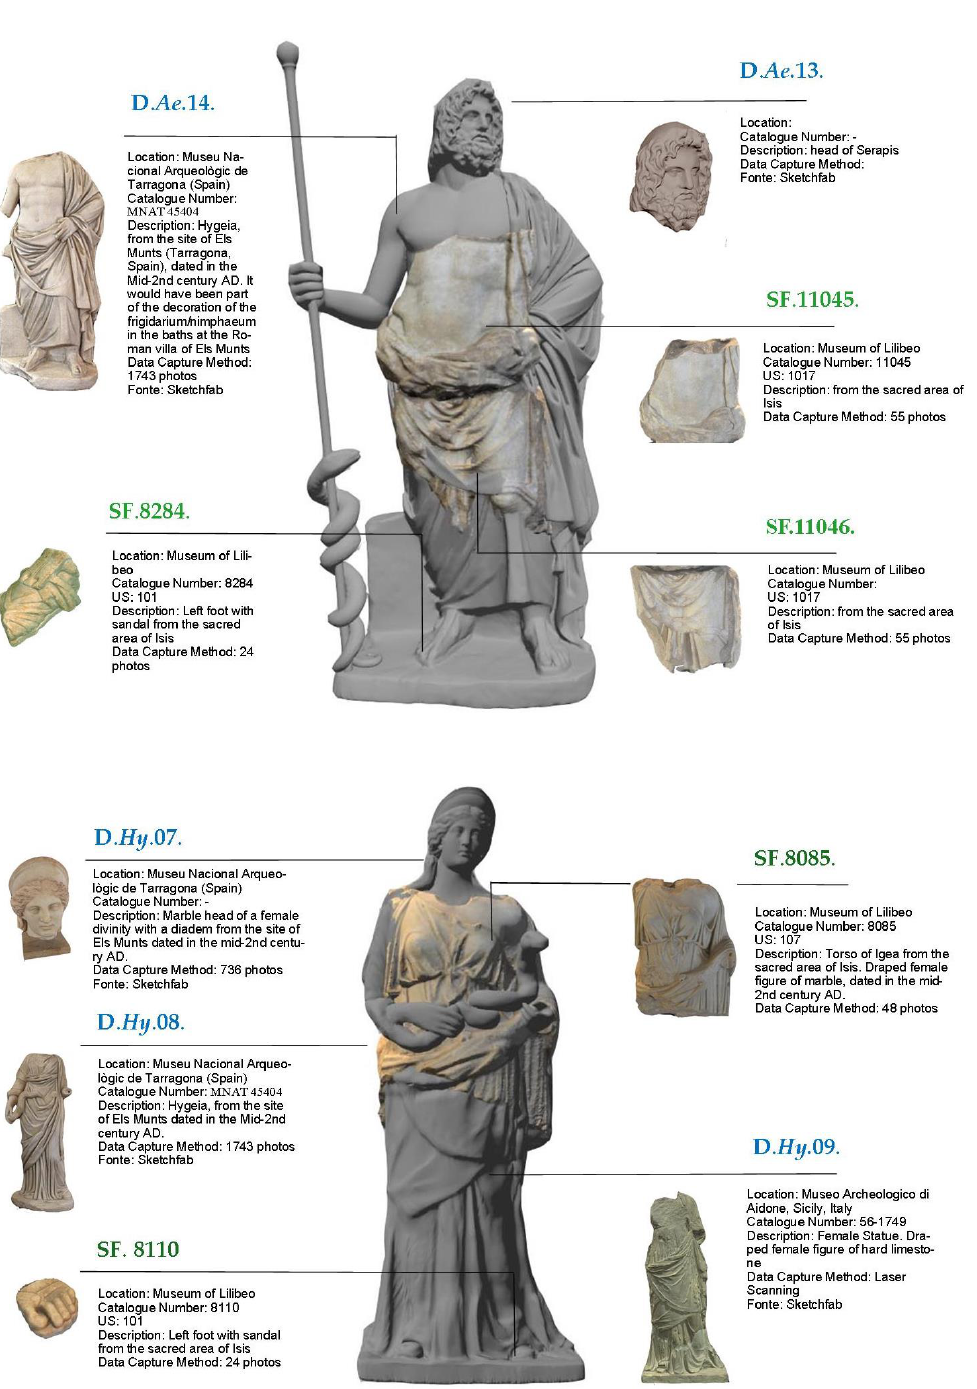
Figure 10. Virtual reconstruction of the Aesculapius and Hygeia statues: high poly model with source tracking.